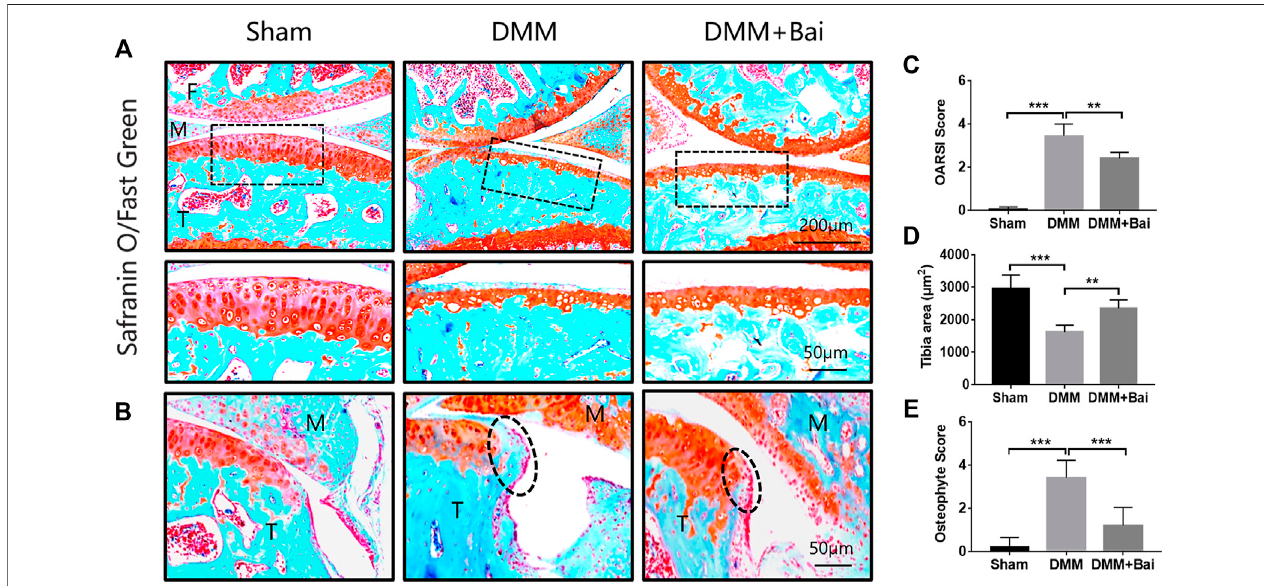
FIGURE 3 | Bai attenuates cartilage degradation and inhibits osteophyte formation. (A) Safranin-O/Fast Green staining of articular cartilage in each group. (B) Osteophytes aremarkedbydotted lines. (C) OARSI scoresforarticularcartilageineach group. (D) Cartilageareaofthetibia. (E) Osteophyte scores.Dataareshown as the mean ± SD. ** p < 0.01, *** p < 0.001 vs. the DMM group, n (cid:1) 5. F: Femur, M: Meniscus, T: